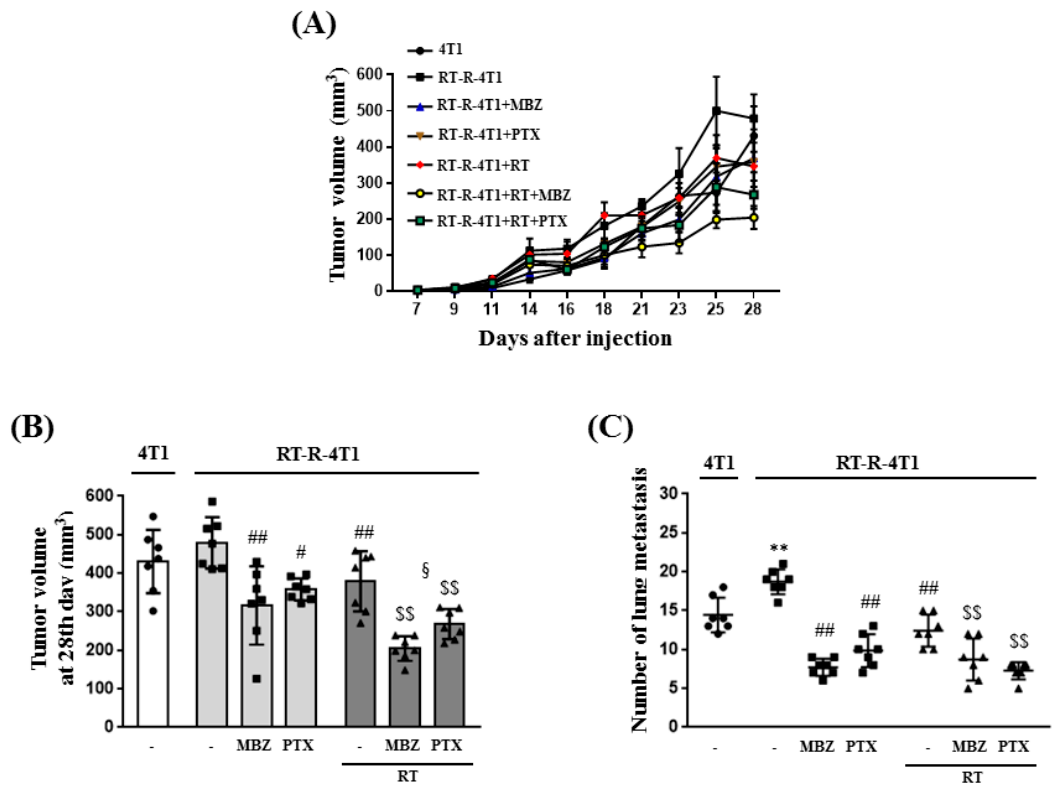
Figure 2. The combination of mebendazole (MBZ) and radiotherapy (RT) increases the anticancer effect of RT on RT-resistant-4T1 (RT-R-4T1) tumor allografts in athymic nude mice. ( A ) Tumor volumes were measured three times a week for four weeks from day seven after the injection of cancer cells. The mice were killed on the 28th day after injection, and tumor volumes ( B ) and number of lung metastases ( C ) were measured. The white bar graph is the tumor volume of 4T1 cells, light gray is the tumor volume of the MBZ or paclitaxel (PTX) alone treatment group of RT-R-4T1 cells, and dark gray is the tumor volume of the RT combined treatment group of RT-R-4T1 cells. The values are presented as the mean ± SD from five independent determinations (** p < 0.01 compared with 4T1; # p < 0.05, ## p < 0.01 compared with the control of RT-R-4T1; $$ p < 0.01 compared with the control of RT; § p < 0.05 compared with RT-R-4T1 +